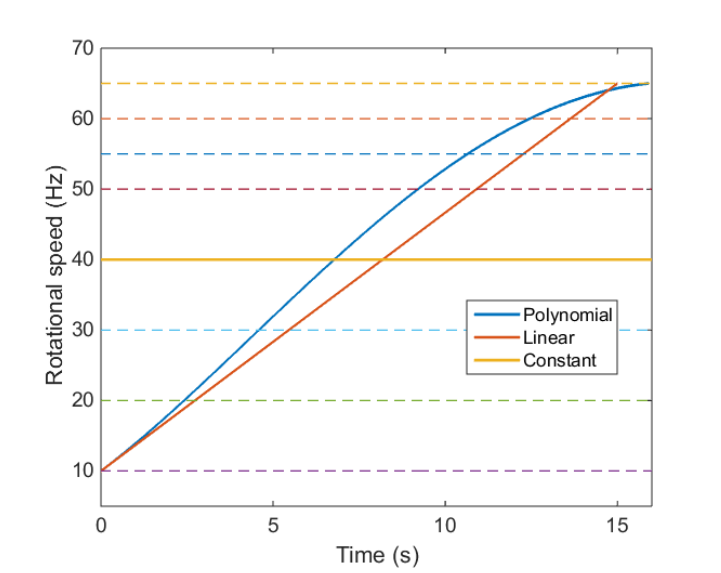
Figure 3. Speed profiles used in the tests. Solid lines show the three main types: constant, linear, and polynomial. Dotted lines refer to the different values of the constant speeds